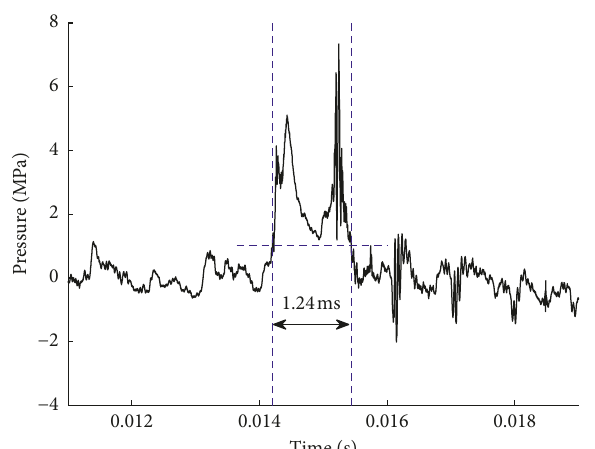
Figure 17: Local enlarged profile of the pressure-time profile at 35mm stand-off in Figure